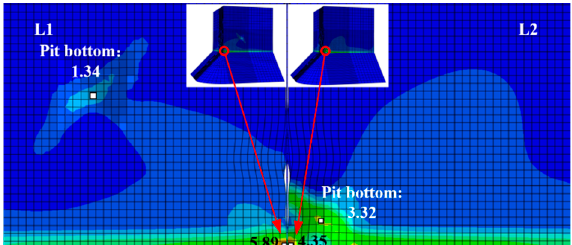
Figure 18. Distribution of equivalent plastic strain ε p at the corner of corroded piers of models L1 and L2.